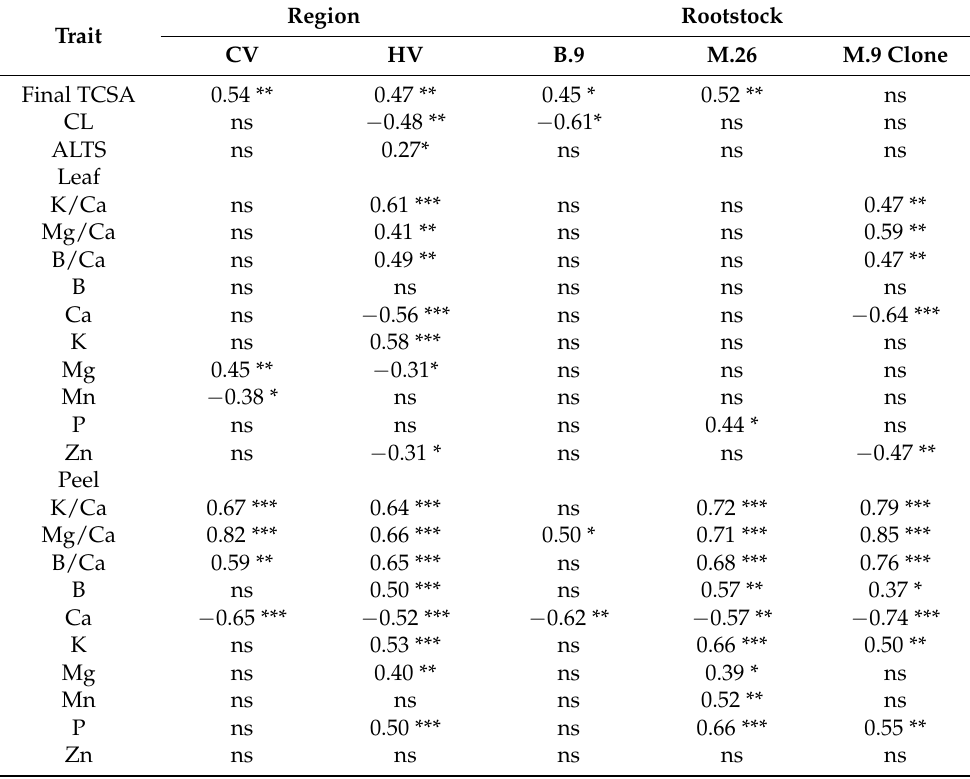
Table 5. Multivariate analysis for bitter pit (%) in ‘Honeycrisp’ apples stored at 2.2 ◦ C for 120 days against all horticultural traits for each rootstock and region with all three years combined (2016–2018).